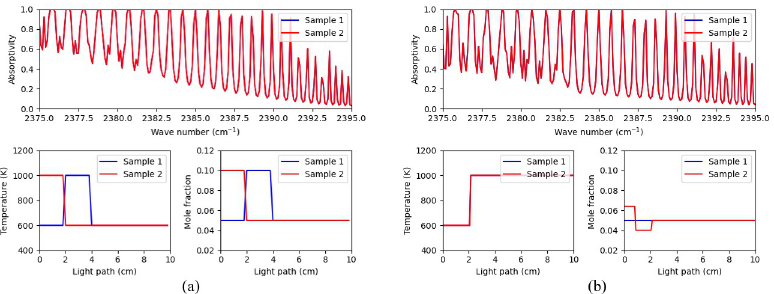
Fig 3. Examples of two types of trivially identical spectra samples. In each figure, the top, bottom left and bottom right subplots represent the spectral profile, the temperature profile and the concentration profile, respectively. (a) Case 1: Spectra generated from the same temperature/concentration distribution but different ordering of the segments. (b) Case 2: Profiles of two spectra with equivalent aggregated sections.